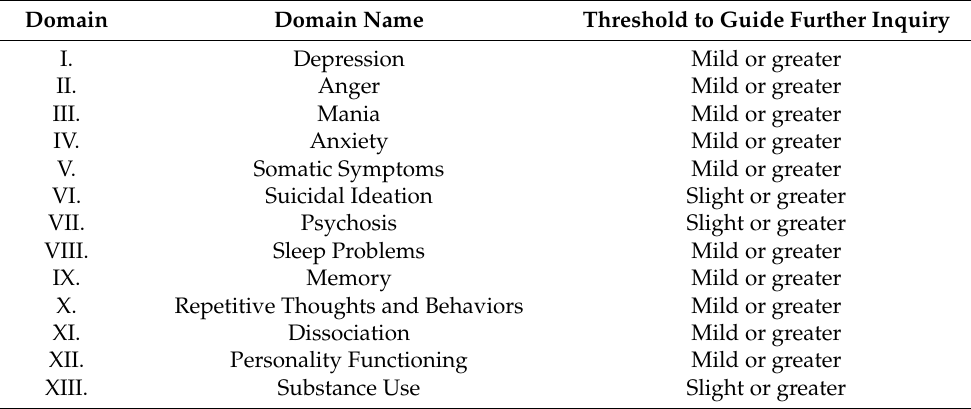
Table 1. DSM V Self-Rated Level 1 Cross-Cutting Symptom Measure questionnaire criteria for identifying patients that require further